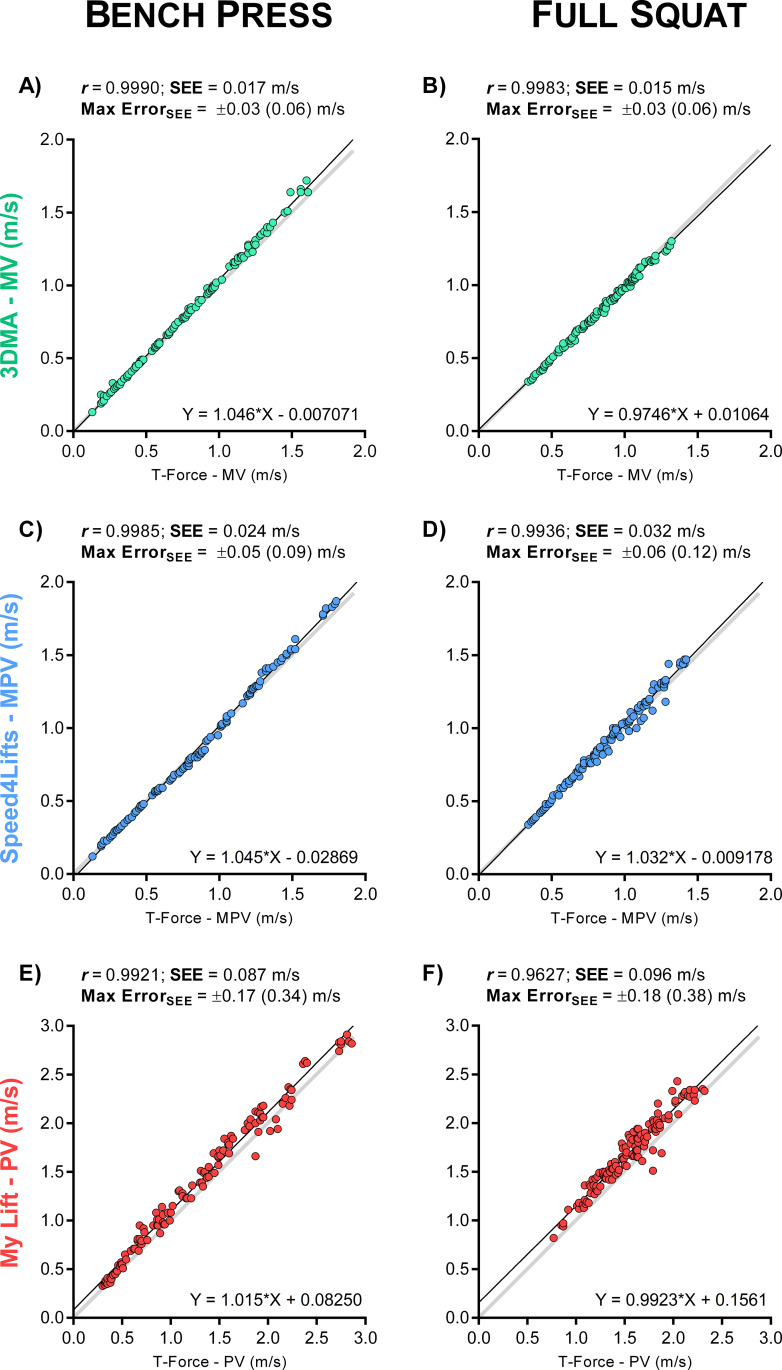
Linear regression analyses for the inter-device agreement in bench press (BP) and full squat (SQ) exercises.Each technology is presented in a different colour and compared against the reference.